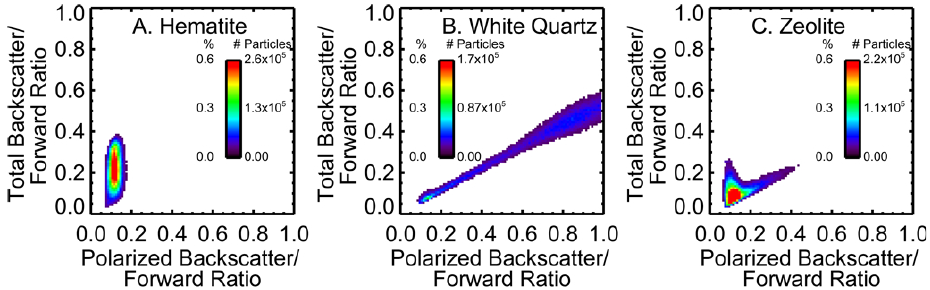
Fig. 10. Polarized backscatter to forward scatter ratio vs. total backscatter to forward scatter ratio for representative members of the optical scattering Groups A (hematite), B (white quartz) and C (zeolite) are